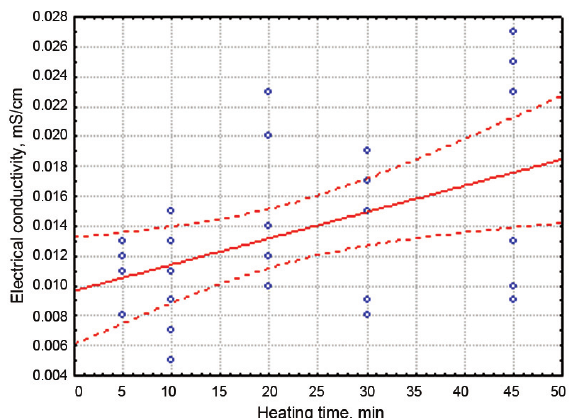
fig. 8. the dependency of actual electrical conductivity on heating time for media 1 and 2